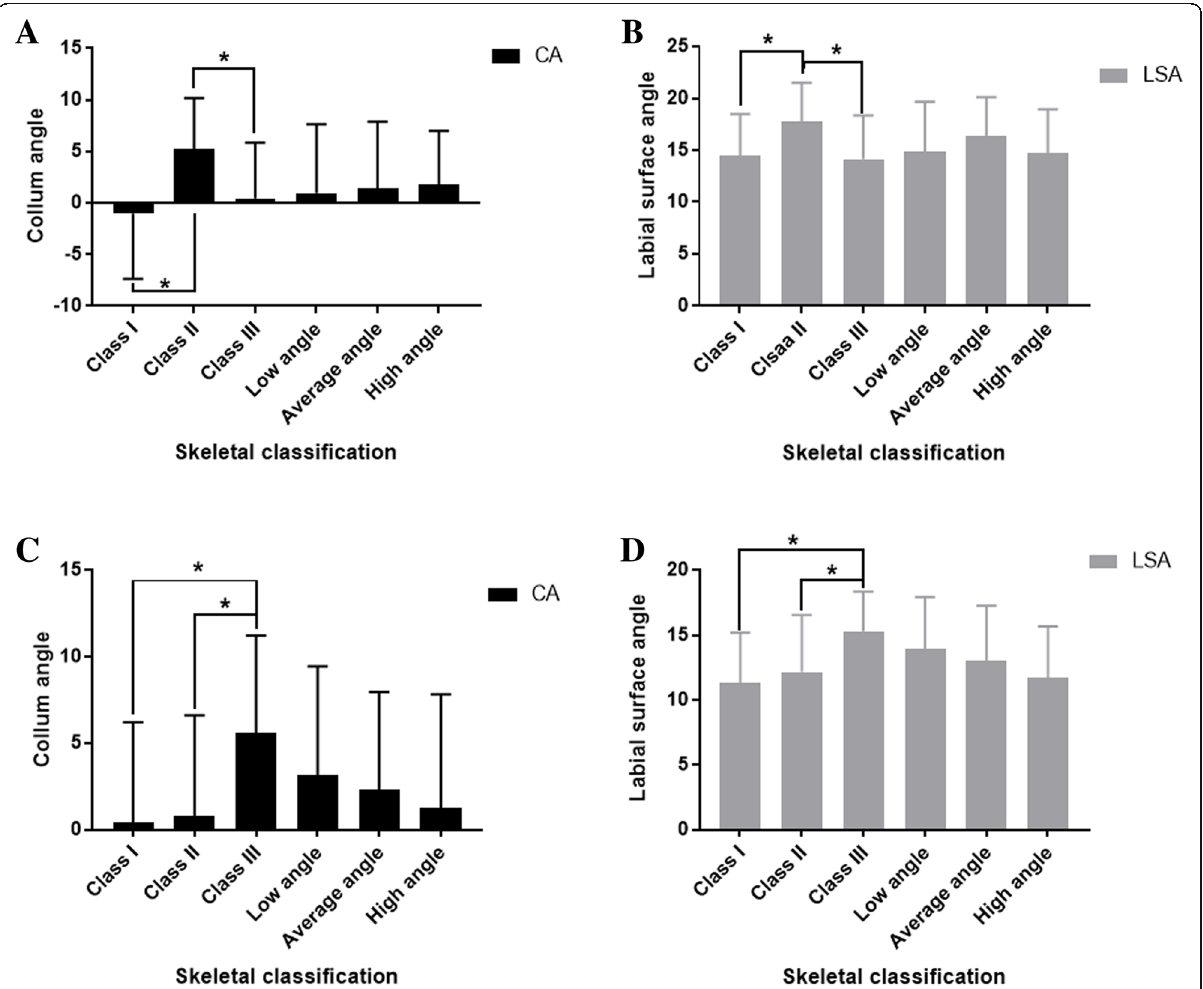
Fig. 5 The value of CA and LSA in maxillary incisor of Class II ( a , b ) and mandibular incisor of Class III ( c , d ) are significantly greater than other groups. There is no statistical difference among different vertical skeletal